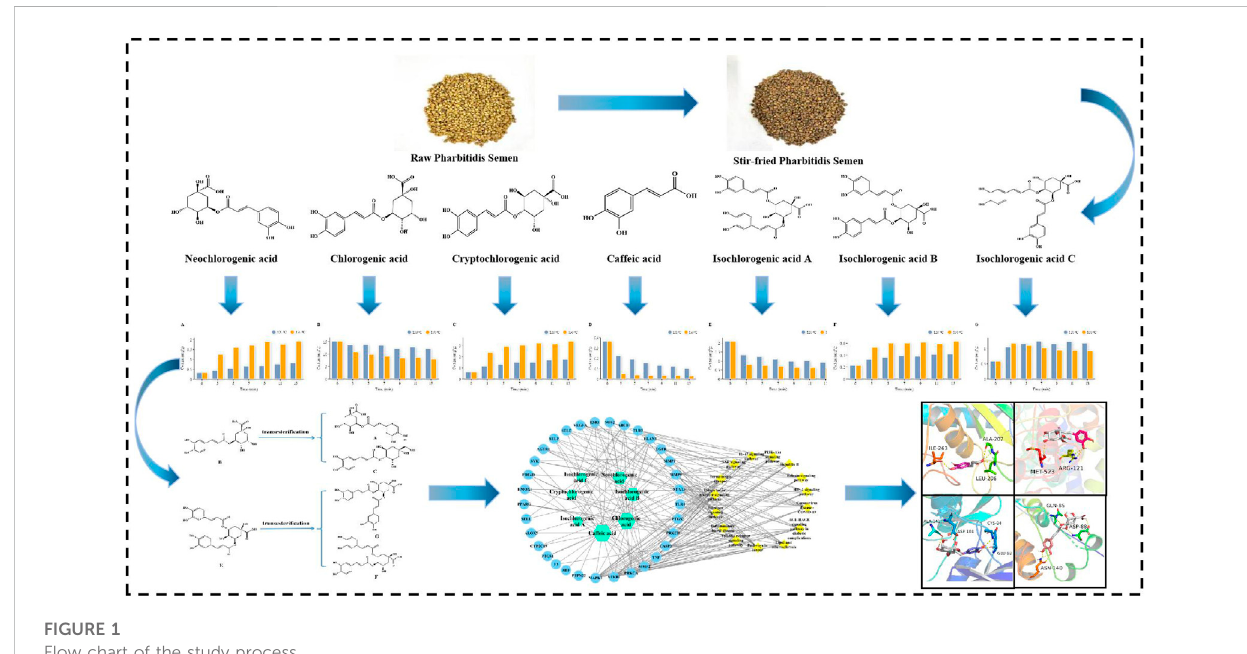
FIGURE 1 Flow chart of the study process.